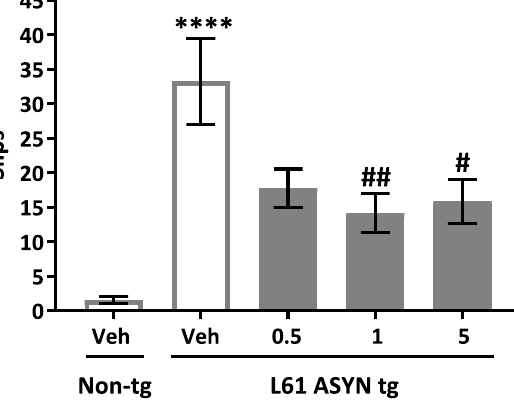
Figure 5. NPT200-11 treatment improves Line 61 ASYN transgenic round beam performance. There was a statistically significant increase in the number of slips in vehicle-treated Line 61 ASYN transgenic control mice on the round beam performance test ( **** p < 0.0001 vs. non-tg/vehicle control group ). There were statistically significant decreases in slips in ASYN transgenic mice treated with either 1 or 5 mg/kg NPT200-11 ( ## p < 0.01 and # p < 0.05 vs. vehicle-treated Line 61 ASYN transgenic mice, respectively) .